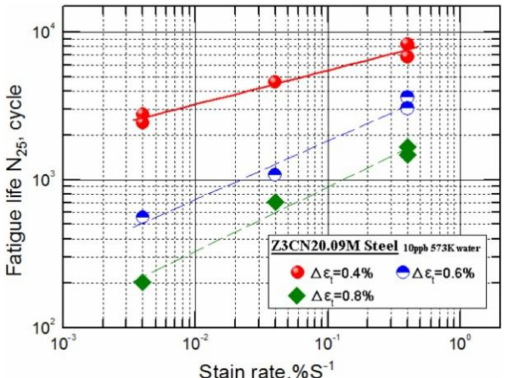
Figure 5. The plot of the fatigue life of the Z3CN20.09M ASS against strain rate in water. The testing corrosive medium was water, and the temperature was 300